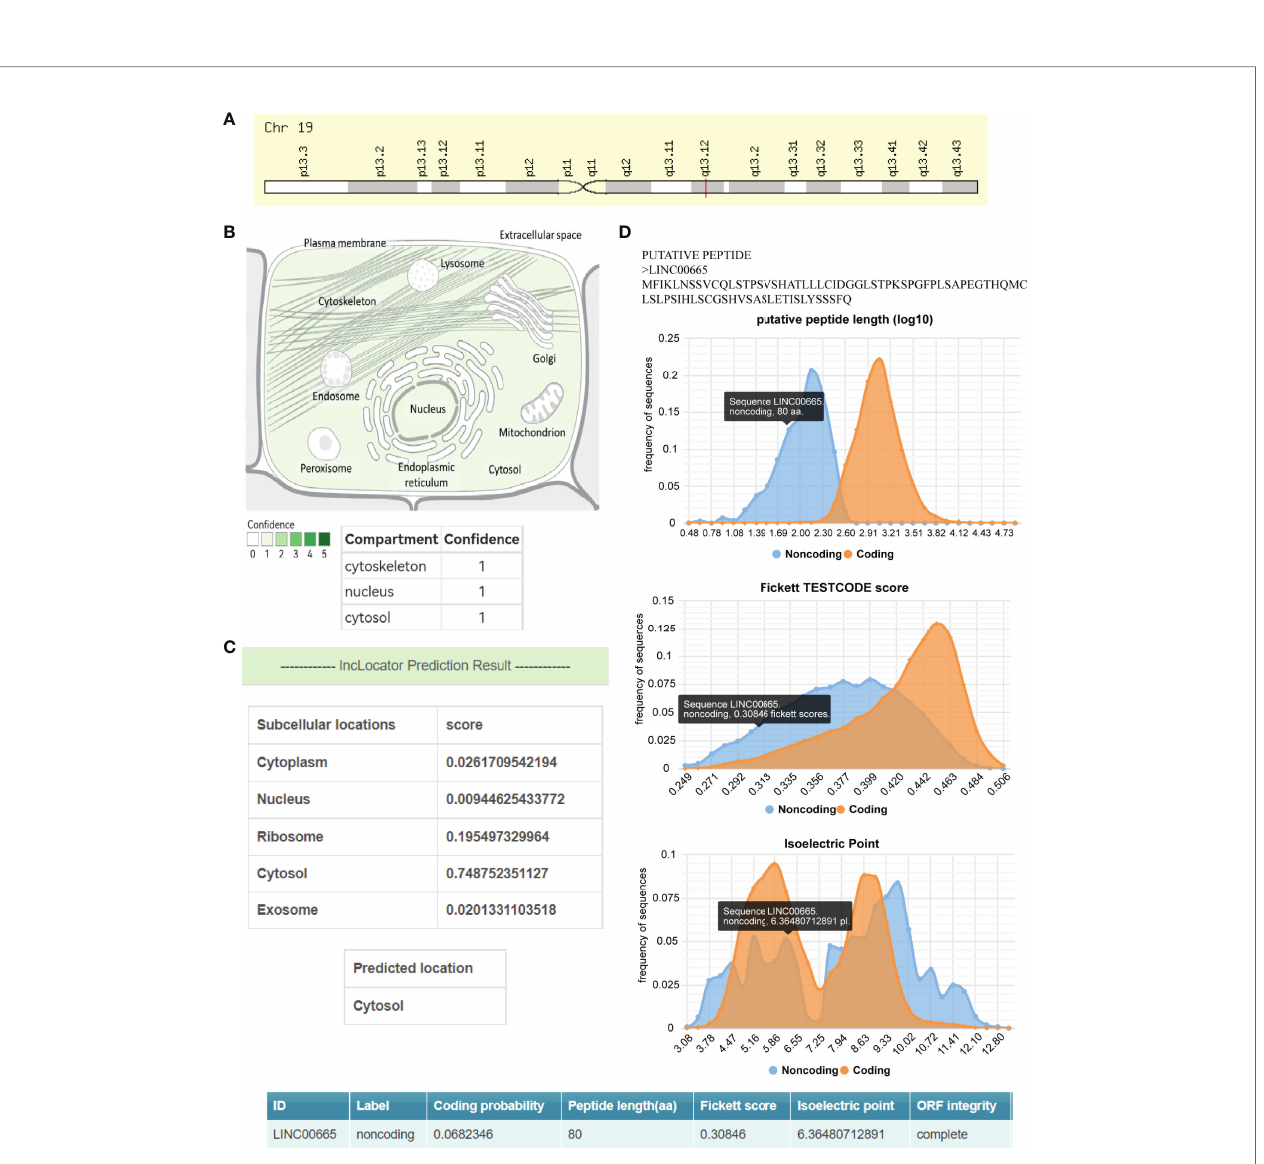
FIGURE 1 | The subcellular localization and coding potential of LINC00665. (A) Chromosome 19q13.12 has a cytogenetic band for LINC00665. (B) LINC00665 expression concentrates in the nucleus, cytosol, and cytoskeleton. (C) The subcellular localization of LINC00665 predicted by lncLocator was the cytoplasm. (D) The protein-coding probability features of LINC00665, including Fickett score, peptide length (synonymous with ORF length), and isoelectric point.